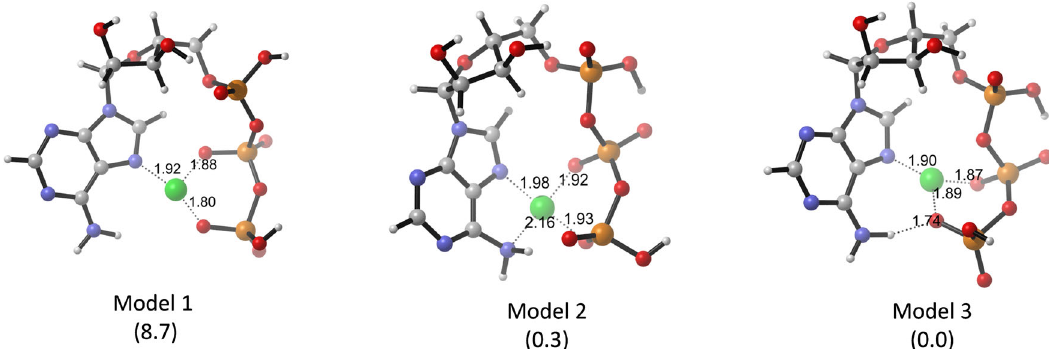
Supplementary Fig. 22. The proposed models of Cu 2 + ⋅ ATP. The relative electronic energies are in the parenthesis with a unit of kcalmol − 1